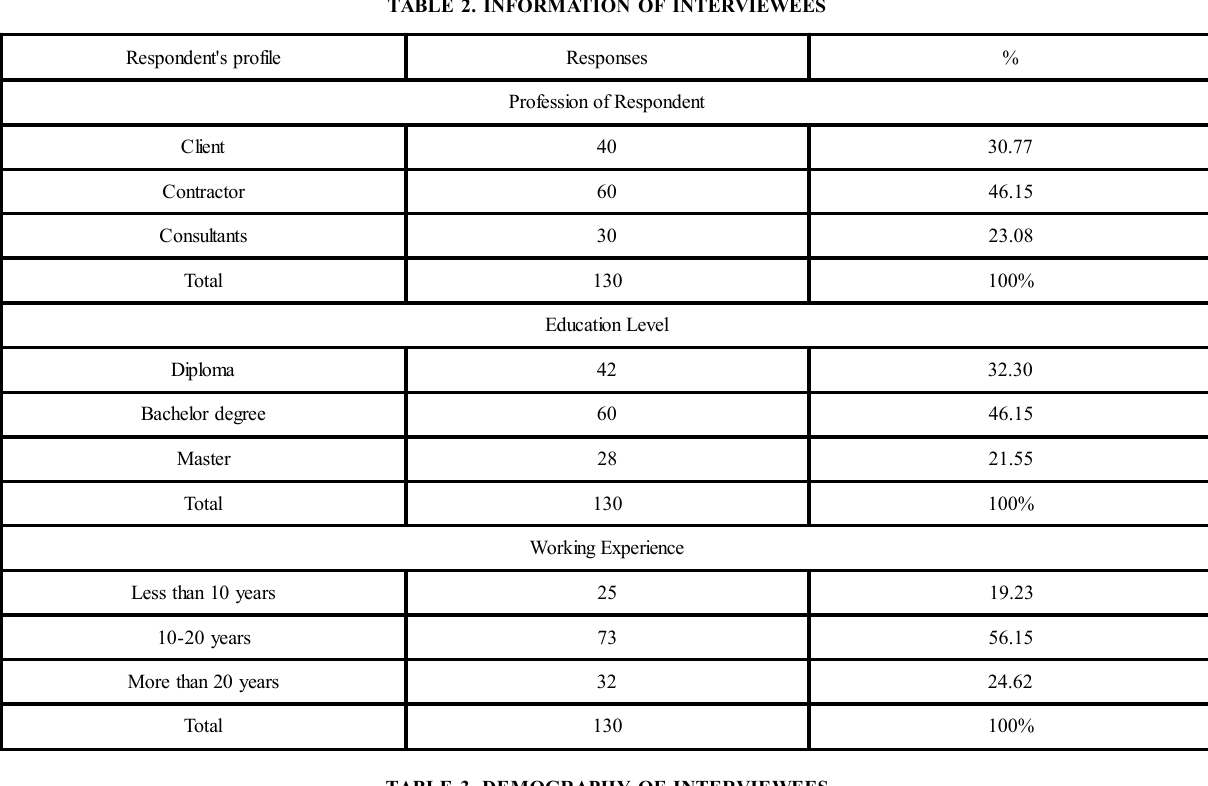
TABLE 2. INFORMATION OF INTERVIEWEES